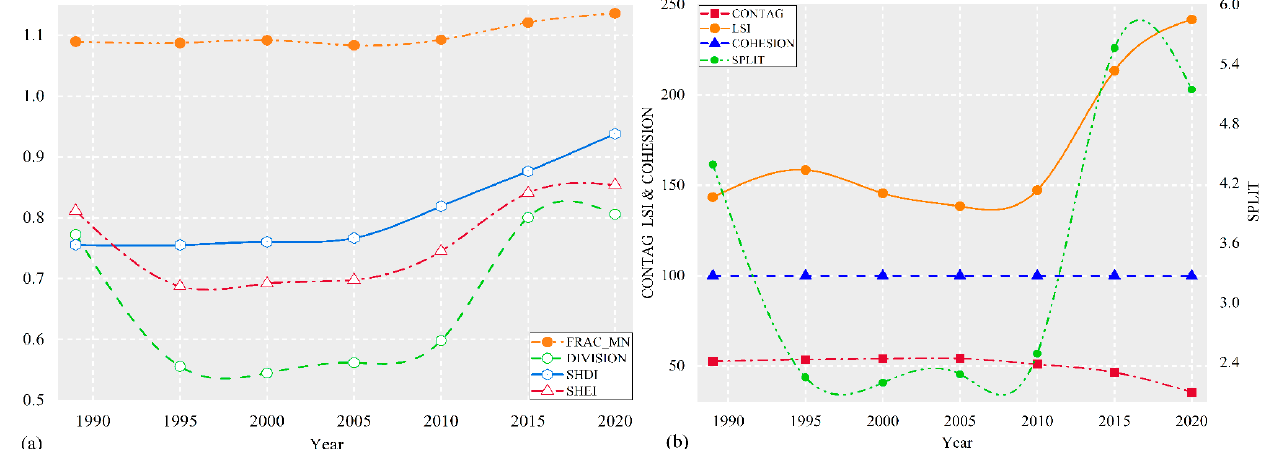
Figure 8. Changes in the landscape dimension of the Poyang Lake area. ( a ) Changes in FRAC_MN, DIVISION, SHDI and SHEI landscape indices during the study period; ( b ) Changes in CONTAG, LSI, COHESION and SPLIT landscape indices during the study period.